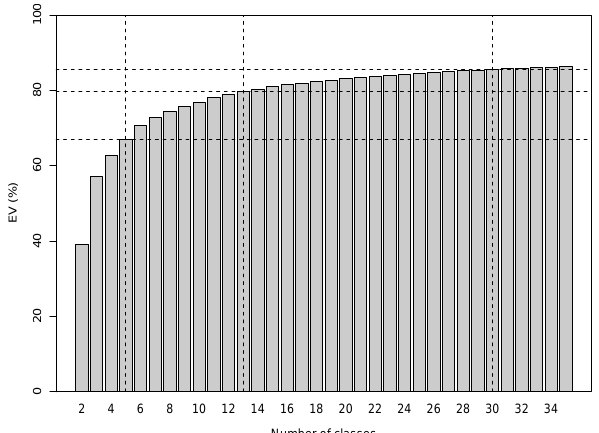
Fig. 4. MRT climate classification predictor importance calculated from 1 WSS values for primary and surrogate splits (see Sect.